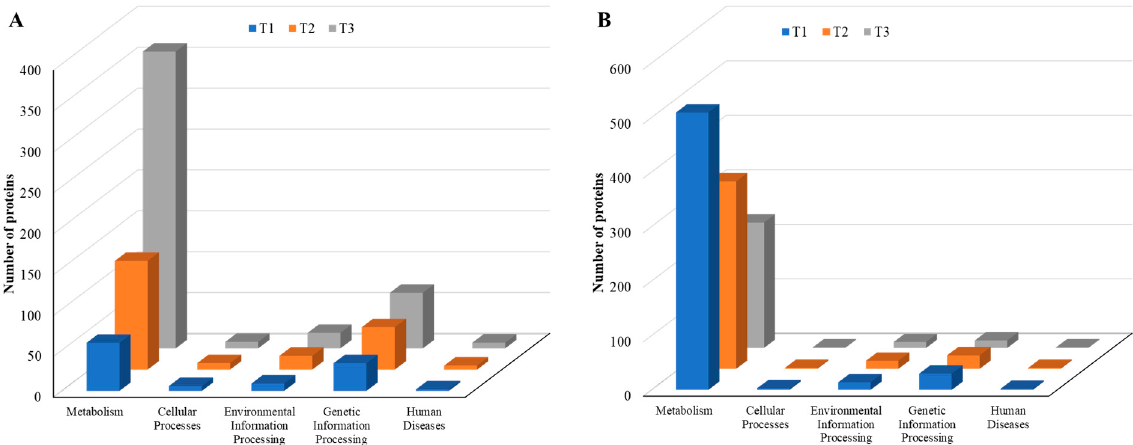
Figure 10. KEGG pathways of five major groups in differentially expressed proteins identified from S. epidermidis strain RP62A biofilms grown with sublethal MIC of TC. ( A ): upregulated proteins, ( B ): downregulated proteins, T1: 1/8 MIC, T2: 1/4 MIC, T3: 1/2 MIC.